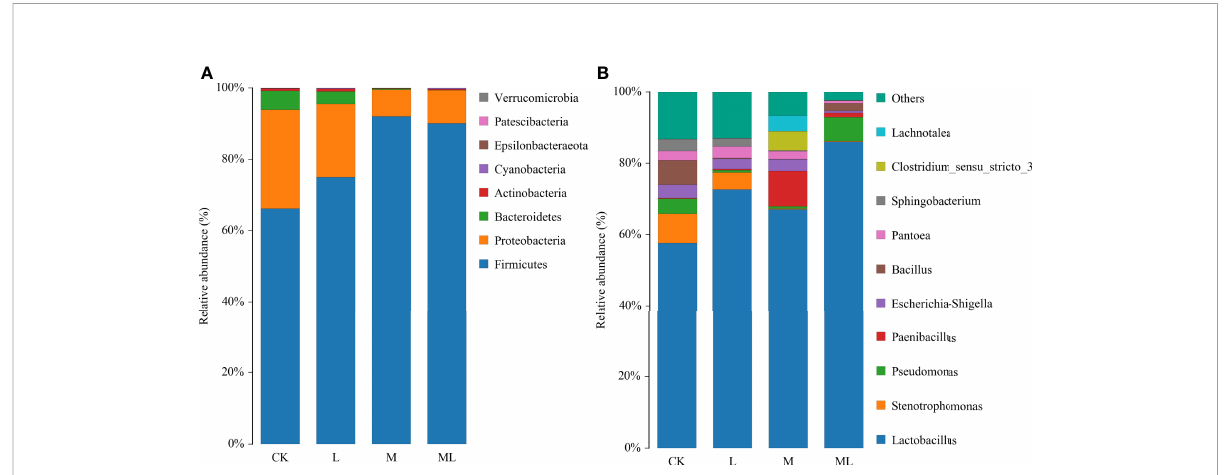
FIGURE 4 The bacterial relative abundance at the phylum and genus levels in mixed silage of KG and CF supplemented with L and M (CK, control; L, lactic acid bacteria; M, molasses; ML, lactic acid bacteria + molasses). (A) Relative abundance of bacteria at the phylum level. (B) Relative abundance of bacteria at the genus